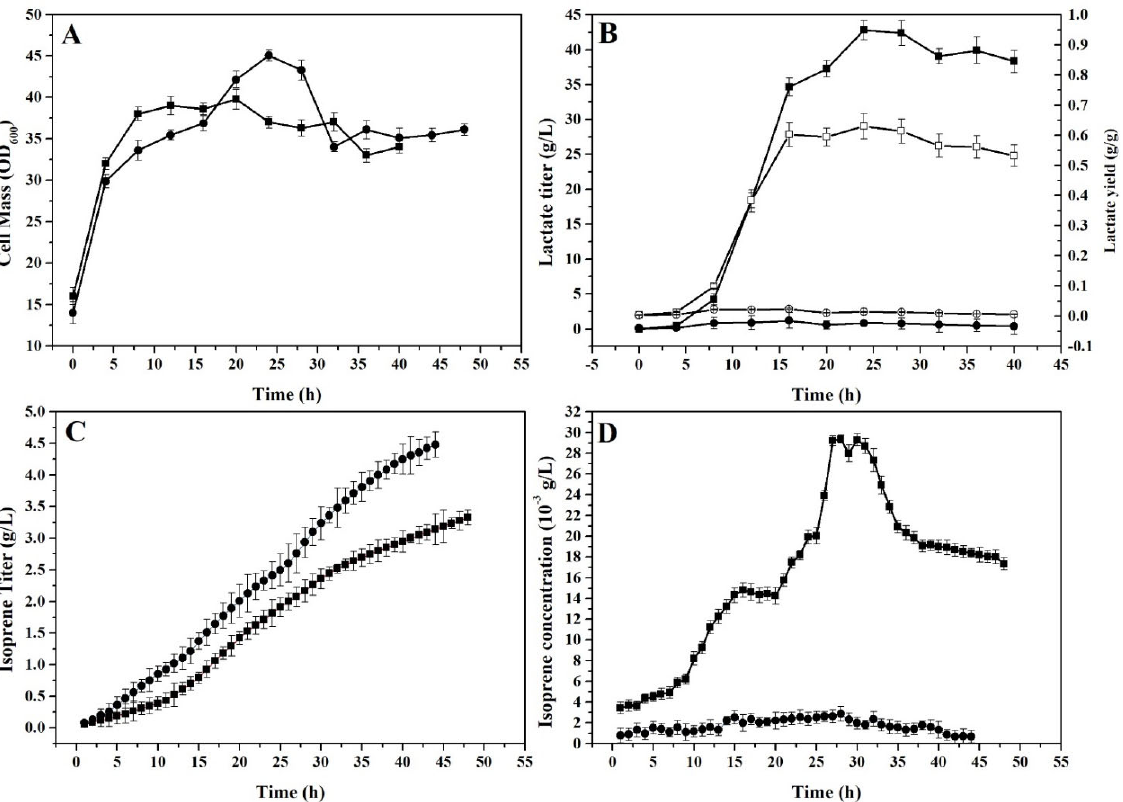
Figure 4. Comparison of the co-production of isoprene and lactate under aerobic and microaerobic conditions in fed-batch fermentation by E. coli CN3: ( A ) Profiles of cell density, ( B ) lactate titer and yield, ( C ) isoprene titer, and ( D ) isoprene concentration in outlet gas. Values of tested samples under aerobic conditions are shown by round dots ( • ), titers of tested samples under microaerobic conditions are shown by square dots ( (cid:4) ), lactate yield under aerobic and microaerobic conditions are shown by hollow circles ( ) and hollow squares ( (cid:3) ), respectively. The data shown are the means of three (cid:35) parallel replicates, and the error bars represent their standard